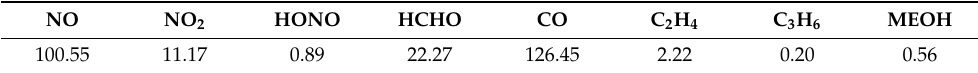
Table 3. Combustion emissions of ozone precursors (tpy) for a hypothetical landfill.